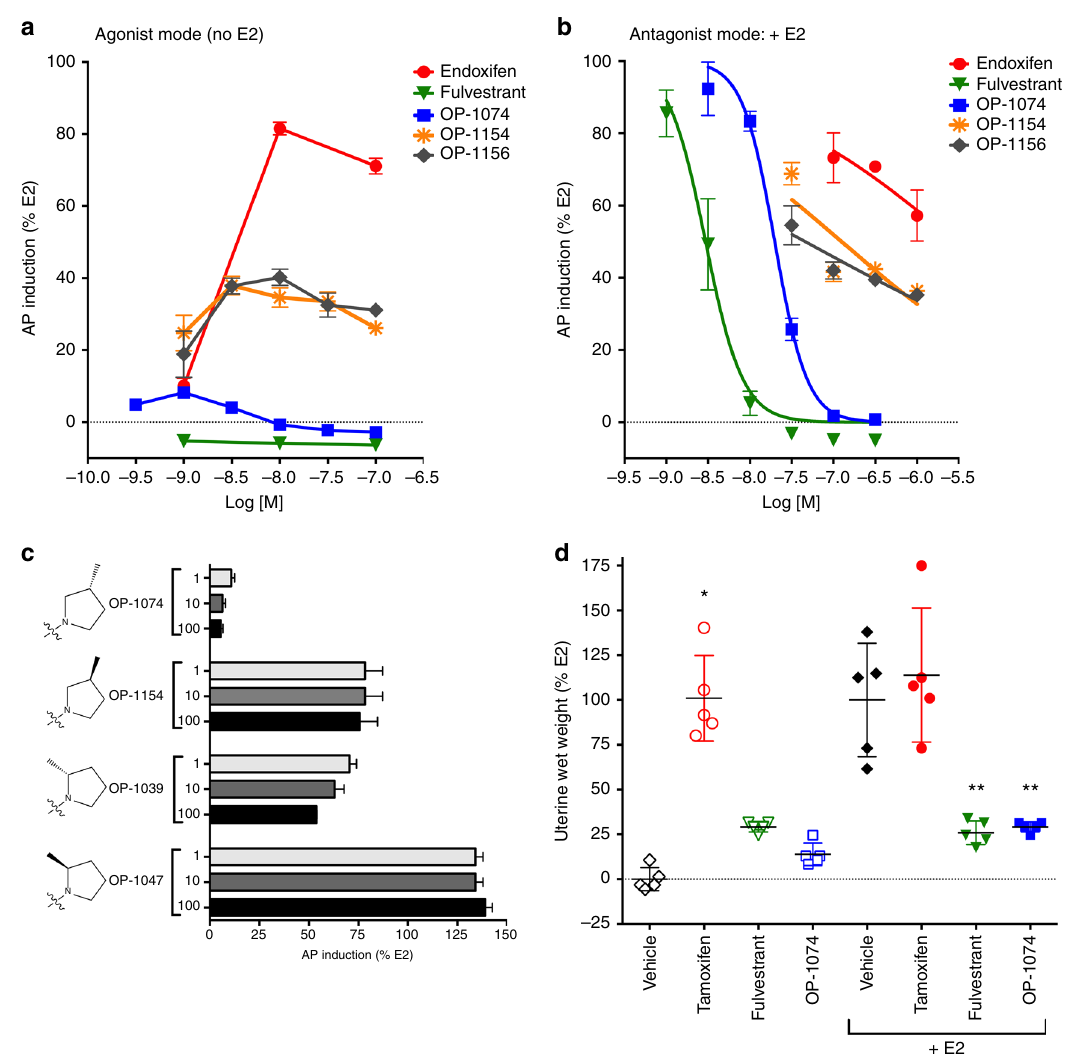
Fig. 2 OP-1074 is a pure antiestrogen and antagonizes uterotrophic activity. a Pure antiestrogens do not stimulate alkaline phosphatase (AP) activity in vitro. Ishikawa cells were treated with compounds for 3 days in the absence of E2 (agonist mode) and assayed for AP activity. Values were normalized for activity of 500 pM E2 in a representative experiment, ±s.e.m., from triplicate wells. b Antagonism of E2-stimulated AP activity. Ishikawa cells were similarly treated with compounds as above but in the presence of 500 pM E2 and assayed for AP activity. c Only the 3R-position of the methylpyrrolidine group lacks AP activity in the agonist mode. Shown is a representative fi gure analyzed and presented as above. Note that compounds tested here were mixtures of approximately equal amounts of active and inactive diastereomers. d Uterine wet weight measured at the end of 3 days after orally treating ovariectomized BALB/c mice daily with vehicle or 50 mg/kg tamoxifen, 100 mg/ml OP-1074 (mixture of active and inactive diastereomers), or subcutaneously with 50 mg/kg fulvestrant. Half the animals in each group were also administered 0.1 μ g/ml E2 subcutaneously. Bars represent mean uterine wet weight ± s.e.m., n = 5 animals. *denotes statistical signi fi cant from vehicle; **denotes statistical signi fi cance from E2 control ( p < 0.05,